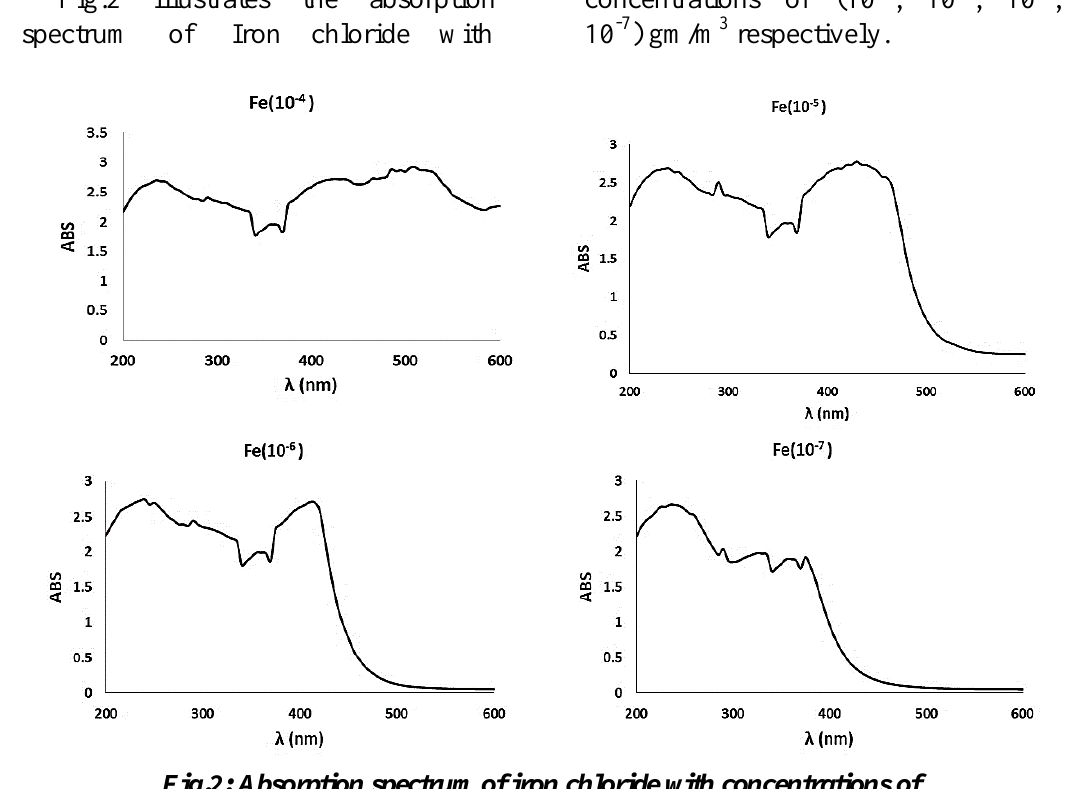
Fig.2 illustrates spectrum